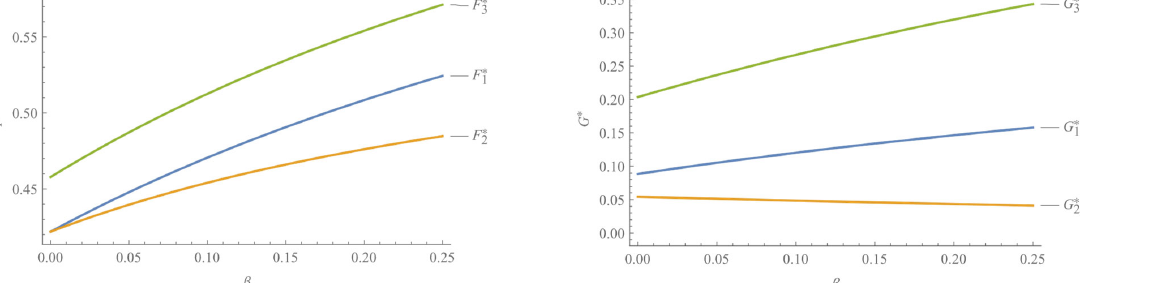
Fig. 1. The impact of manufacturer’s risk aversion on the level of social welfare